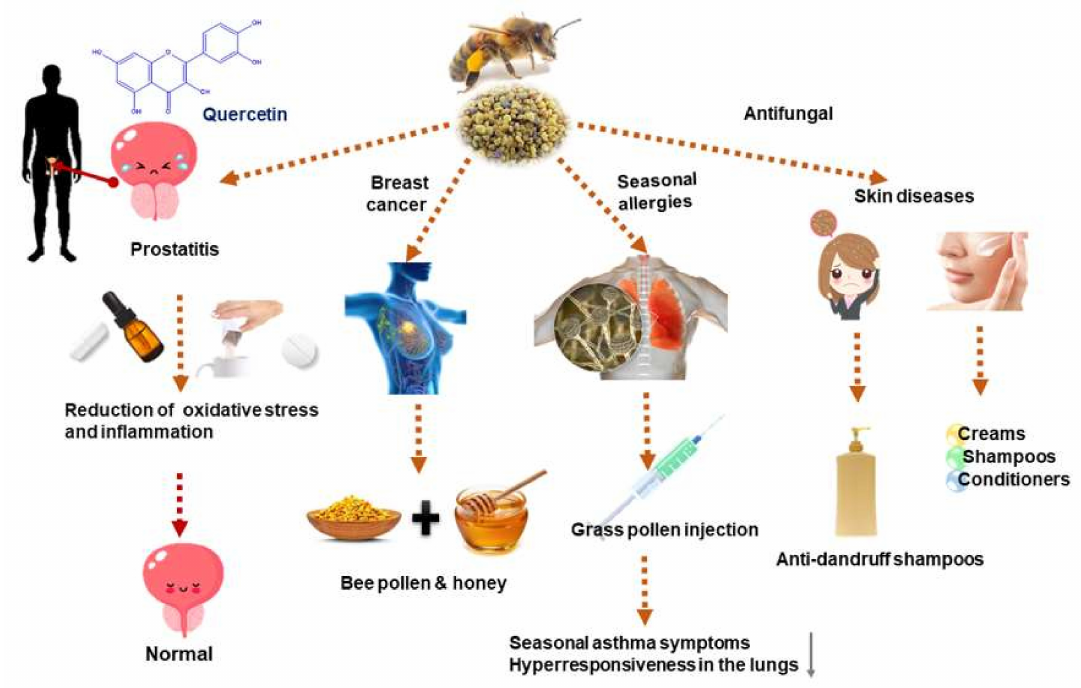
Figure 1. Clinical trials involving bee pollen. A double-blind, placebo-controlled clinical trial was conducted in 47 patients with benign prostatic hyperplasia (BPH) to investigate the efficacy and safety of the 12-week intake of food supplemented with honeybee-collected pollen lump extract (HPLE). The participants were randomly assigned to three study groups: placebo or group P (0 mg HPLE per day), lower dose or group L (160 mg HPLE per day), and high dose or group H (320 mg HPLE per day). The maximum flow rate was significantly higher in group H (P0.05), but not in groups L or P. While the residual urine volume increased significantly in groups L and P (P0.05 each), it decreased in group H. There were no HPLE-related health risks or clinically significant laboratory abnormalities found